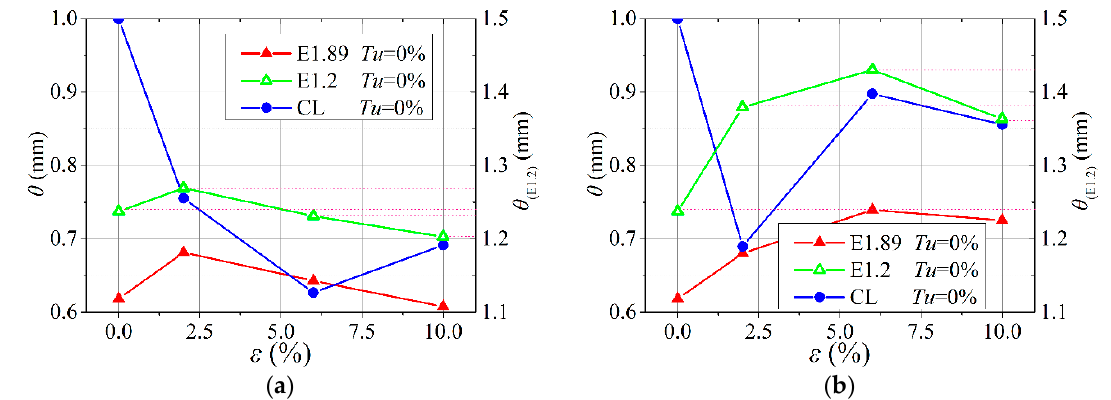
Figure 15. The θ of different leading edges at the point of S = 50 in the low turbulence condition: ( a ) BLUNT series; ( b ) WEDGE series.